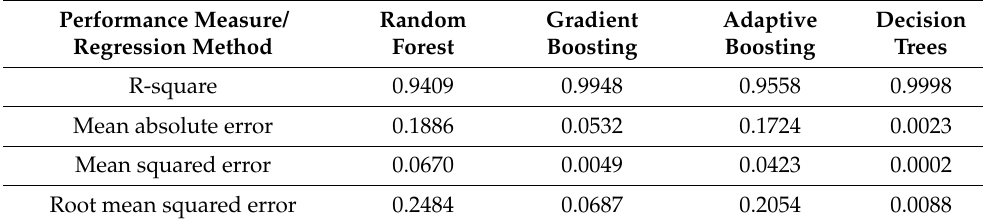
Table 1. Summary of the regression methods used.